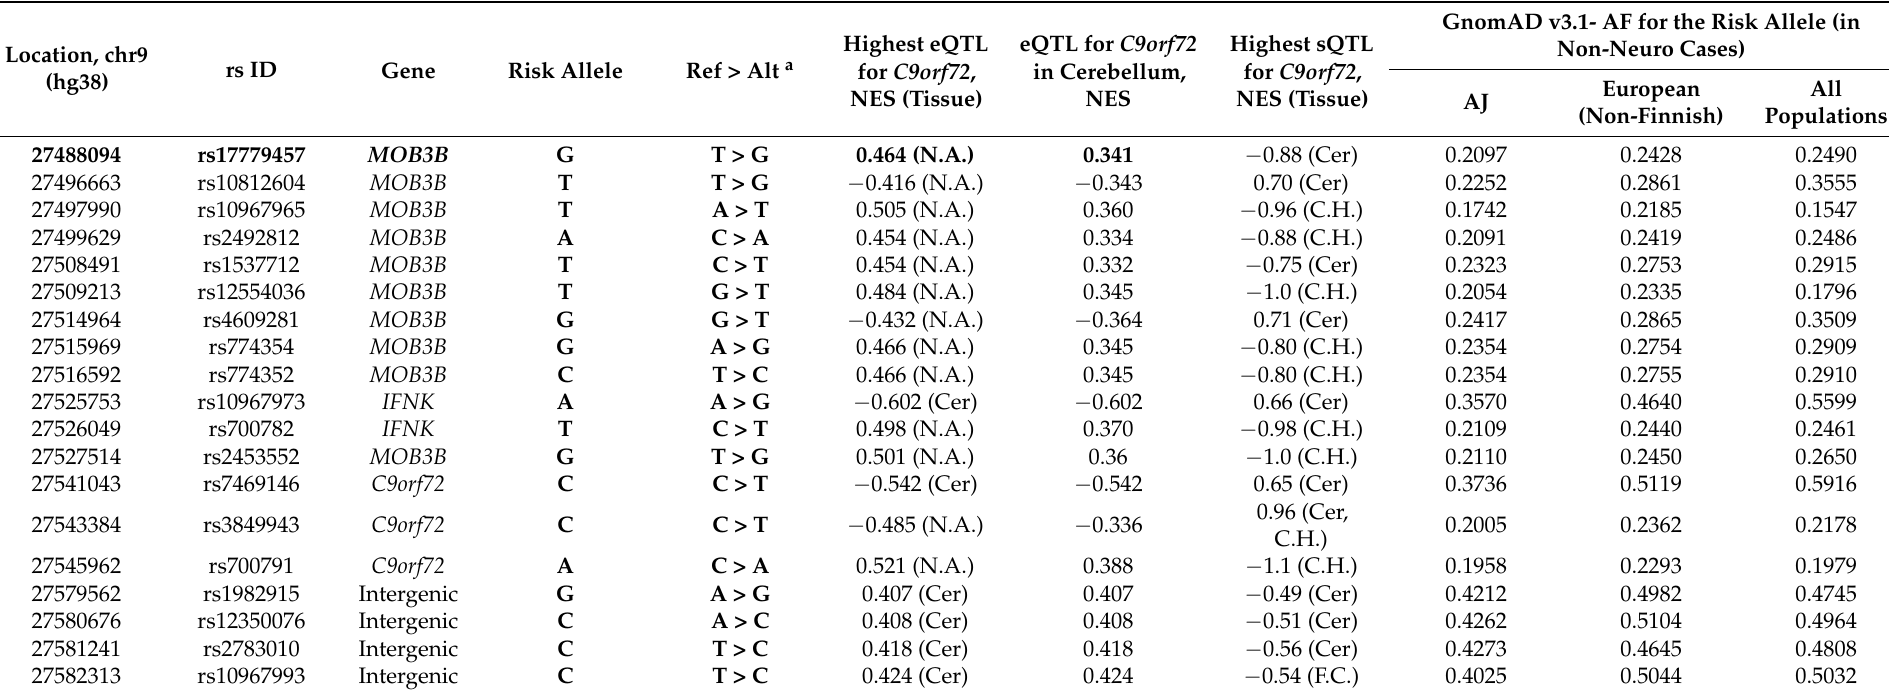
Table 3. The effect of the 19 variations within the risk-haplotype on RNA expression levels and splice variants as reported by GTEx